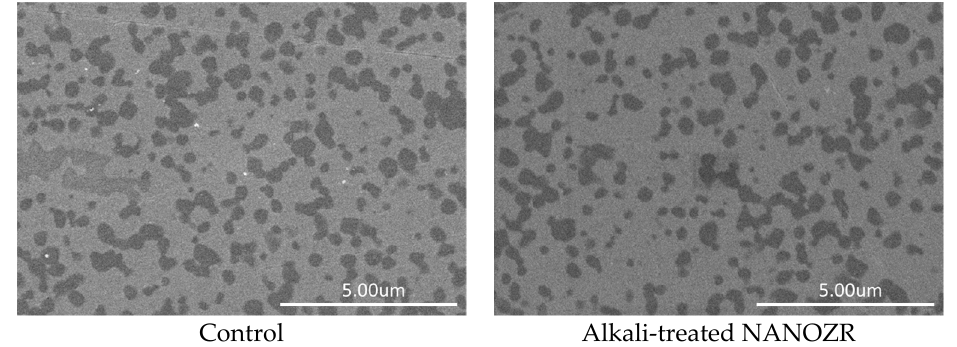
Figure 1. SEM micrographs of control and test groups.